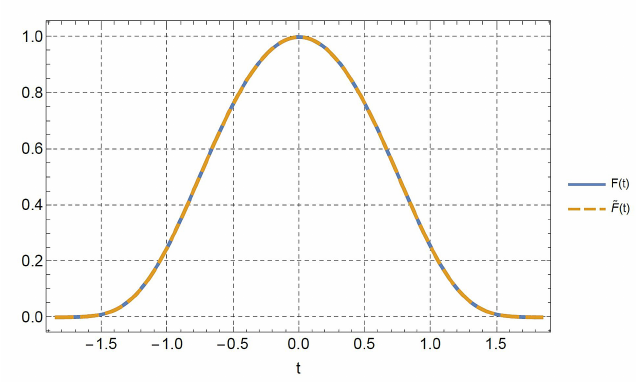
Figure 1. Graph of the function F ( t ) = exp [ − ( sinh ( t )) 2 ] .